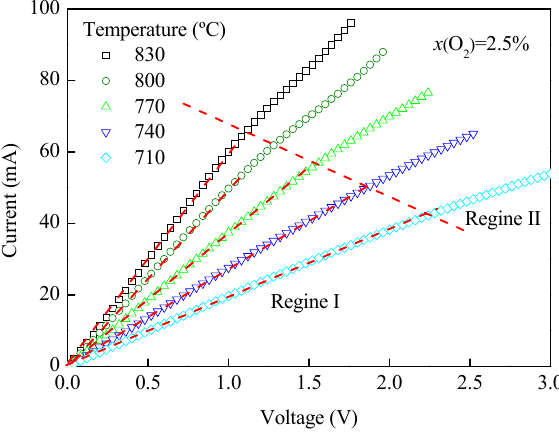
Figure 6. I-V characteristic curves at different temperatures.